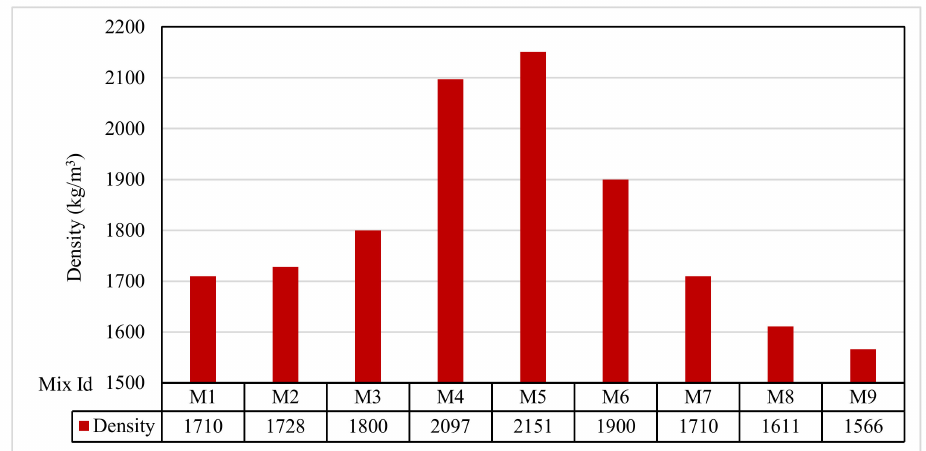
Figure 7. The density test results.